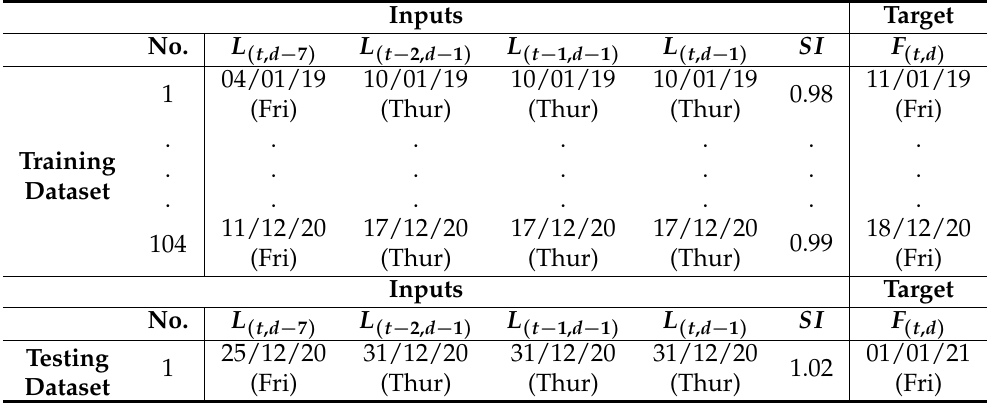
Table 1. Same day training data arrangement for testing target 1 January 2021 at time t